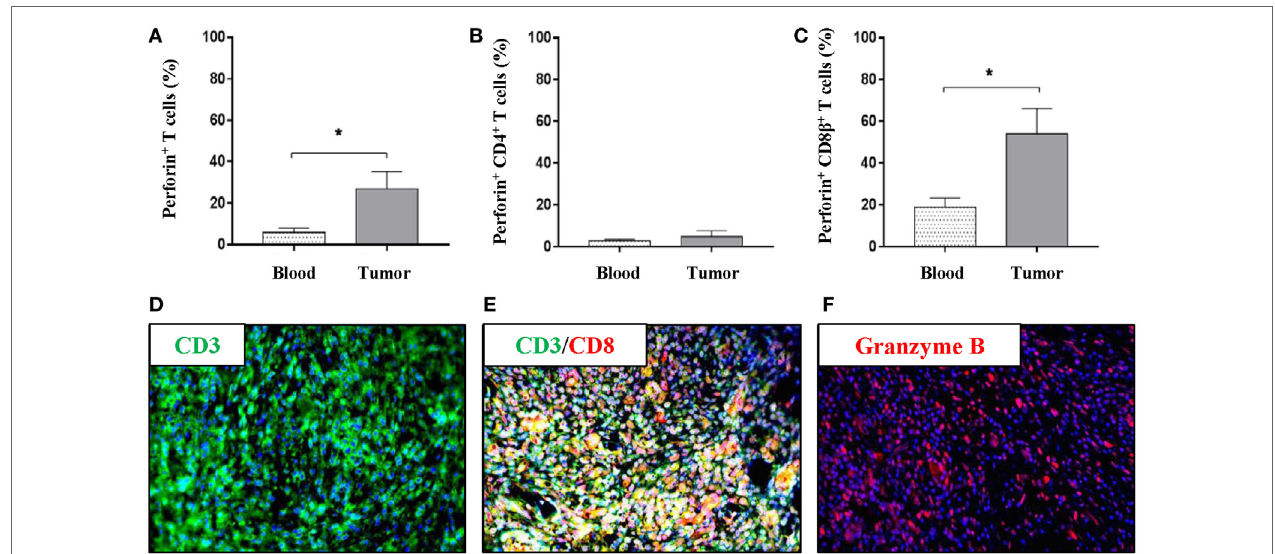
FigUre 3 | The tumor microenvironment of Oncopigs is infiltrated by perforin + and granzyme B + immune cells. Oncopigs were subcutaneously injected with AdCre to induce tumor formation. PBMCs and tumor samples were harvested 7–21 days post injection and analyzed by flow cytometry. Cells were pre-gated on viable, single lymphocytes. (a) Numbers represent perforin + cells as a percentage of live CD3 + -gated cells. (B) Percentage of perforin + cells in live, CD3 + CD4 + -gated cells. (c) Perforin + cells as a percentage of live, CD3 + CD8 β + -gated cells. Bars represent mean values ± SEM, and data are from two independent experiments ( n = 4–5). Statistical evaluations were performed by unpaired Student’s t -test. (D) Tissue sections were harvested from Oncopig tumors isolated 7–21 days post AdCre injection. Detection of CD3 + cells (green) in a tumor cross-section by immunofluorescence. (e) Immunofluorescence image detecting co-localization of CD3 + (green) and CD8 α + (red) cells in the tumor. (F) Detection of granzyme B + cells (red) in a tumor cross-section. DAPI (blue) used as nuclear counterstain for all immunofluorescence images (* P < 0.05).